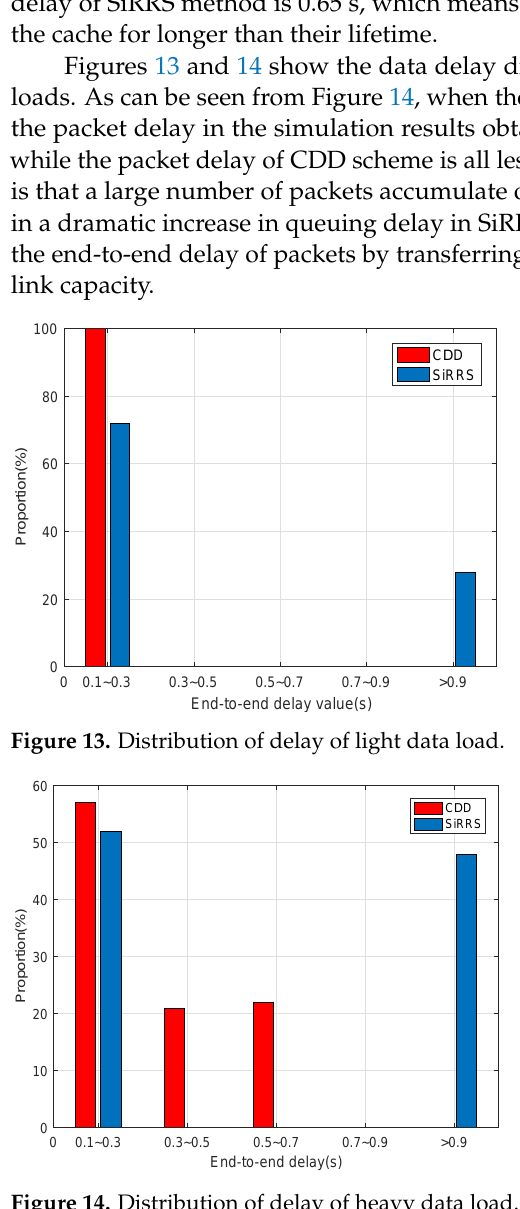
Figure 14. Distribution of delay of heavy data